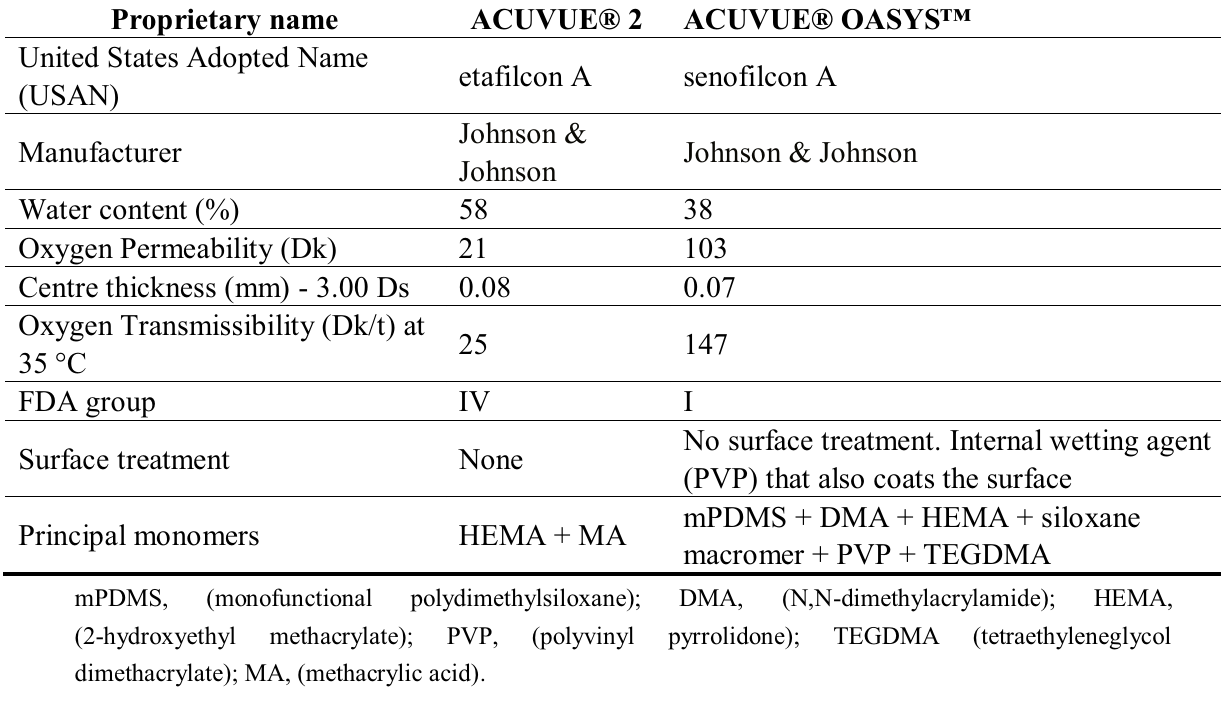
Table 1. Properties of contact lens materials evaluated in the study.